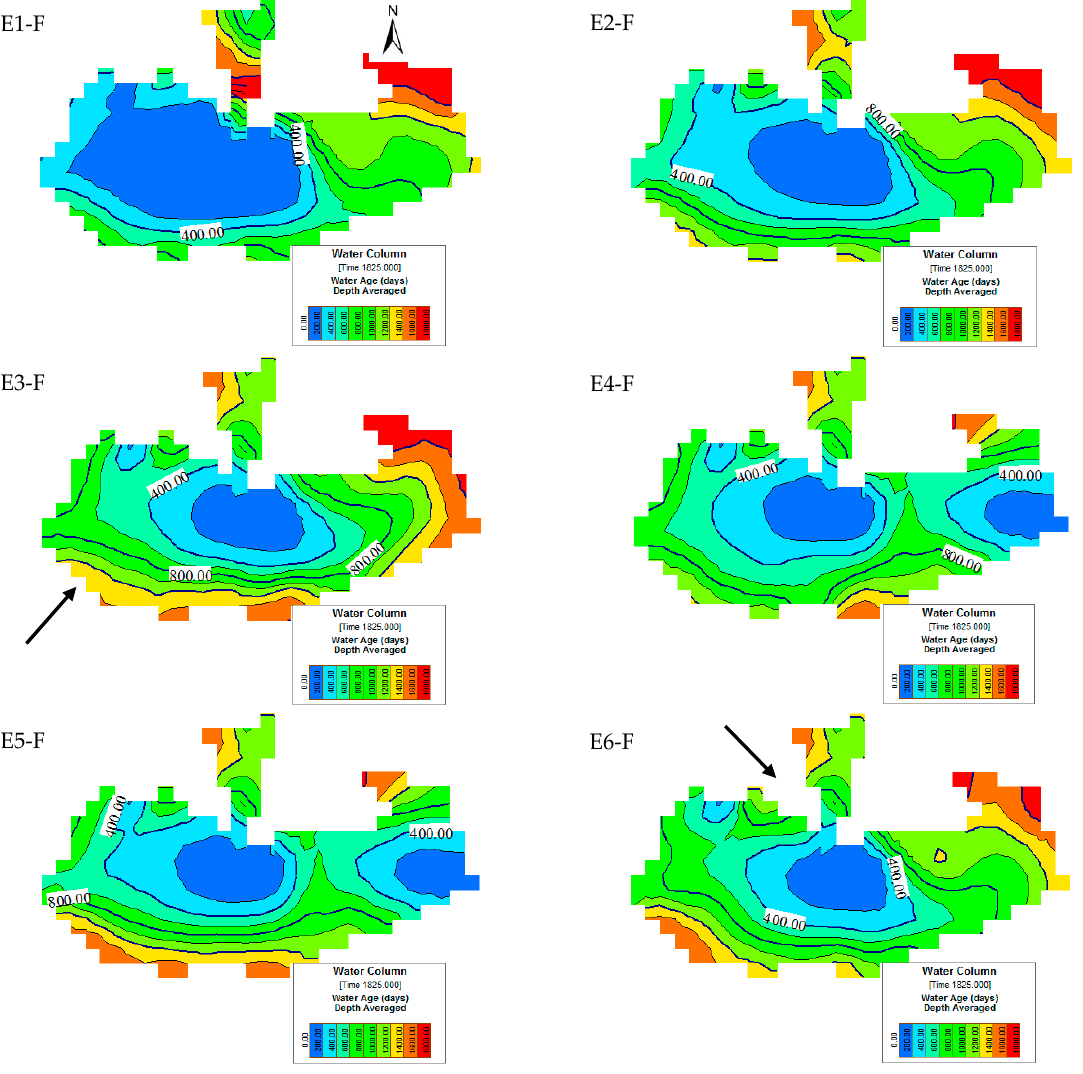
Figure 5. The water age distribution in the small lake under different scenarios after 5 years’ simulation (considering farmland drainages, and the black arrows represent the schematic wind direction in the two comparing scenarios E3 and E6). Table 3. The water age (day) of the sites 1–8 (S1, S2, S3, S4, S5, S6, S7, and S8 in Figure 2) after 5